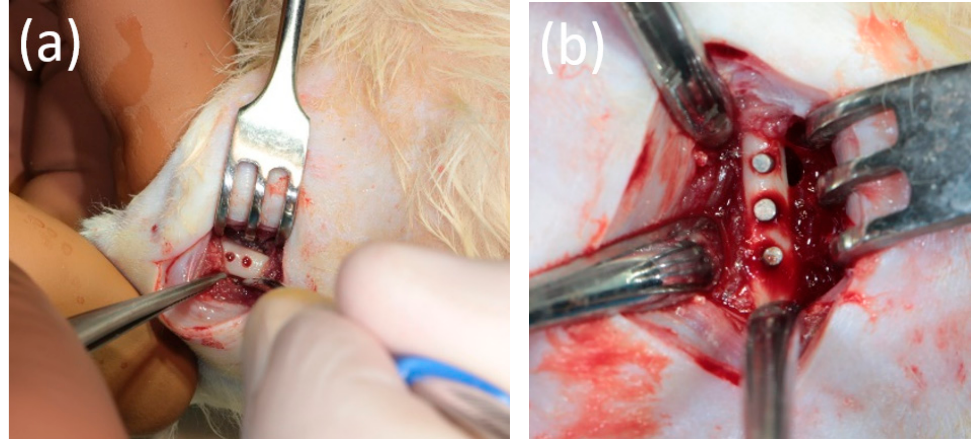
Figure 2. The appearance of the Mg-2Zn-2Ga alloy implants. Figure 3. ( a ) The femur of an animal with holes for the implants. ( b ) The appearance of the operating areas after